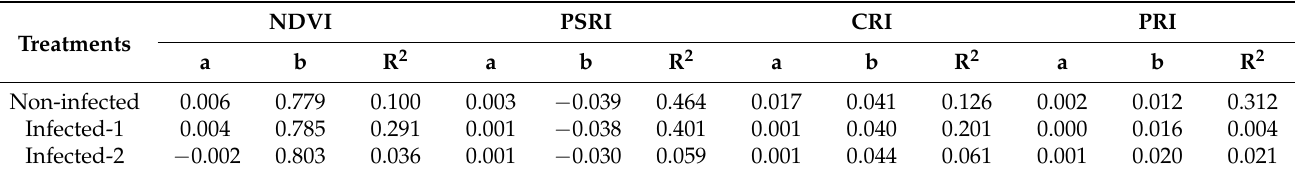
Figure 2. Leaf spectral reflectance measurements of normalised difference vegetation index ( A ; NDVI), carotenoid reflectance index ( B ; CRI), plant senescence reflectance index ( C ; PSRI), photochemical reflectance index ( D ; PRI) of non-infected, artificial infected with B. cinerea disc (Infected-1) and infected with pathogen spore suspension (Infected-2) of “Little Gem” lettuce after 12, 18, 36, 60, and 84 h of artificial infection. Table 3. Coefficients for linear regression equations presented in Figure 2, in the form of y = ax + b, and their correlation coefficients (R 2